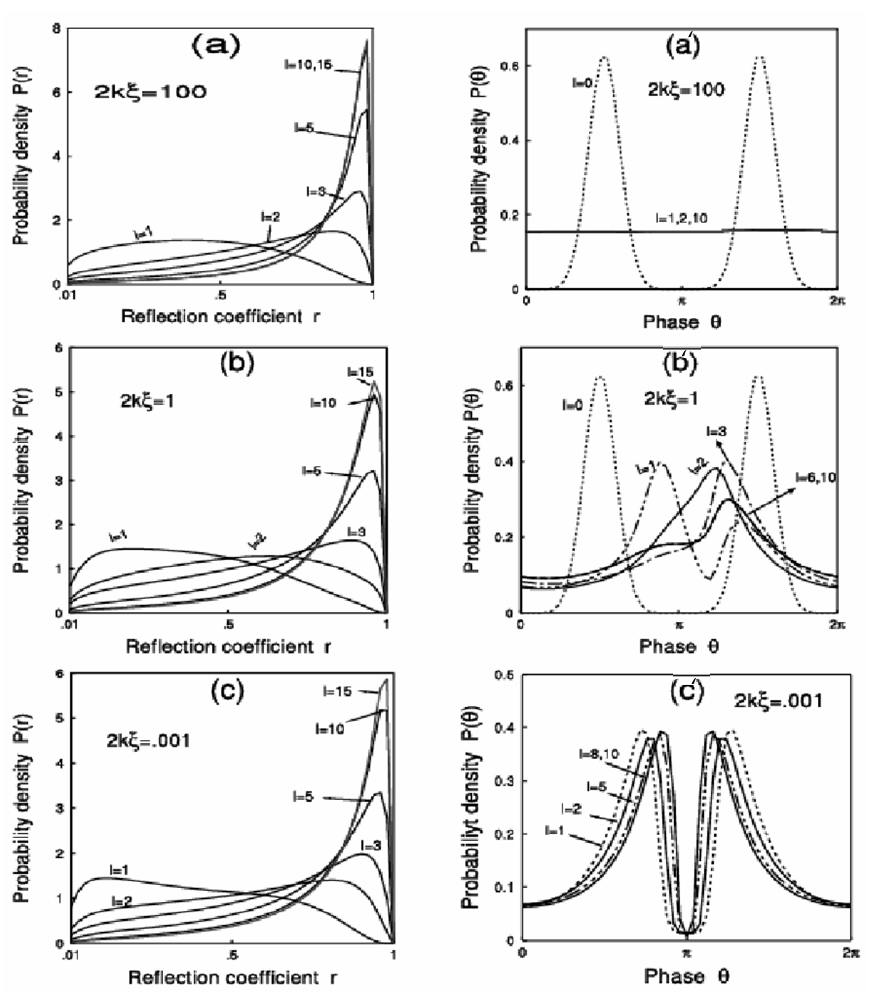
Figure 5. Marginal probability distribution P ( r ) for the fixed disorder strength parameters: ( a ) Weak disorder, 2 k ξ = 100, ( b ) Intermediate/medium disorder, 2 k ξ = 1, and ( c ) Strong disorder, 2 k ξ = 0.001 (corresponding to Figures 2–4) for different sample lengths. Corresponding marginal phase distributions P ( θ ) for: ( a’ ) Weak disorder, 2 k ξ = 100, ( b’ ) Intermediate/medium disorder, 2 k ξ = 1, and ( c’ ) Strong disorder, 2 k ξ = 0.001 for the different sample lengths l .